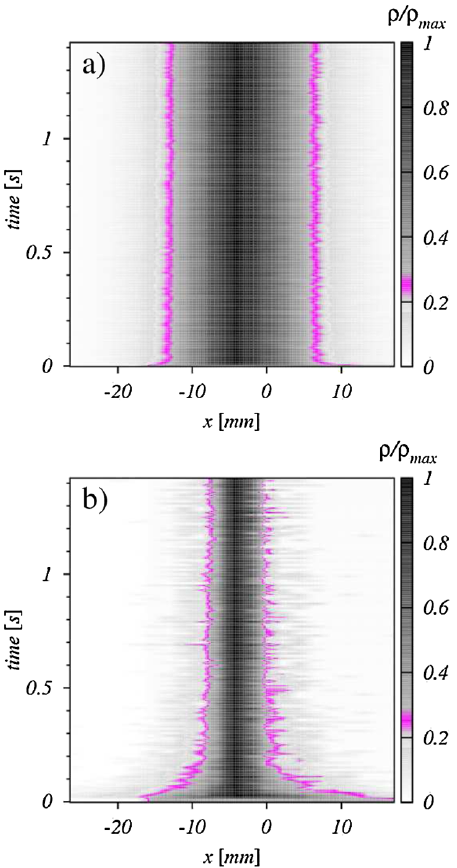
FIG. 5. Low intensity coasting beam: Time evolution of beam profile for (a) Q x ¼ 4 : 3185 , Q y ¼ 3 : 245 ; (b) Q x ¼ 4 : 3325 , Q : 245 y ¼ 3